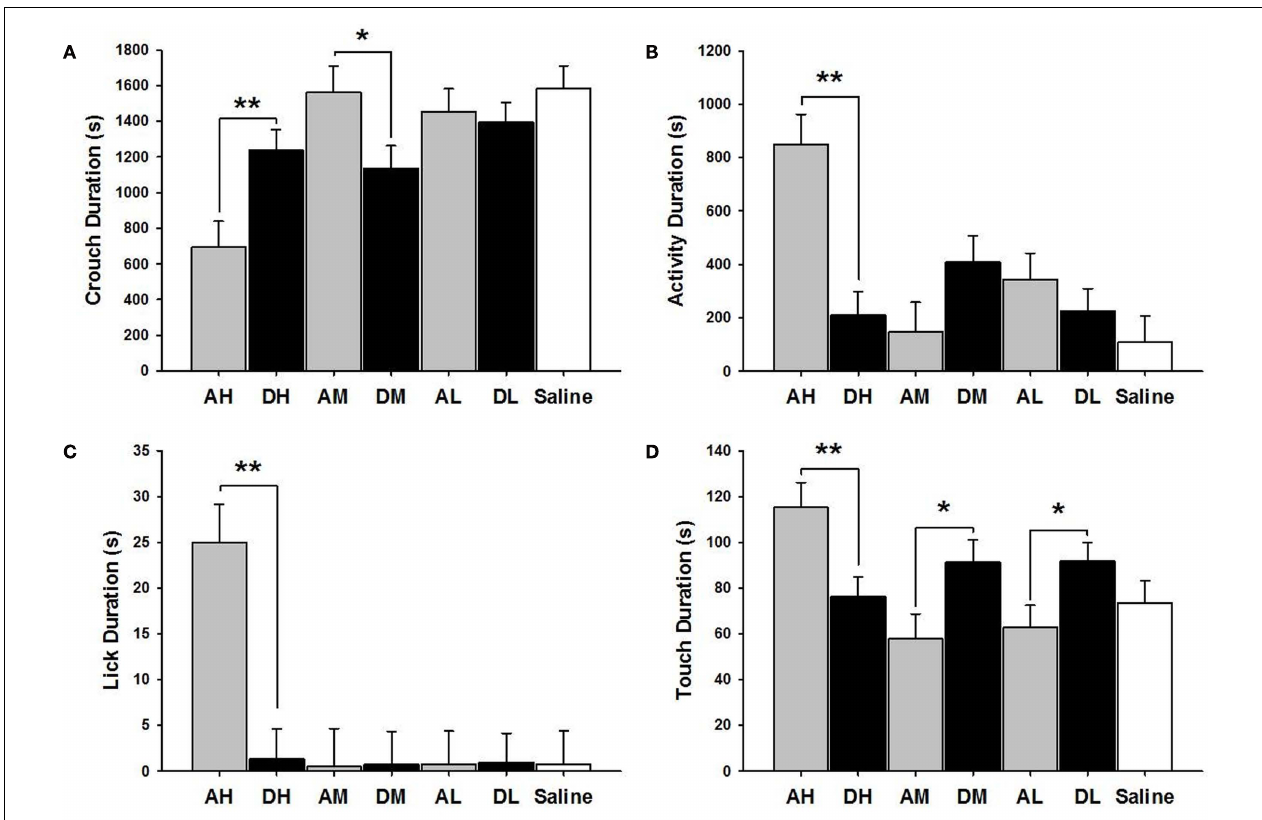
desipramine high (5mg/kg); DM, desipramine medium (5mg/kg); DL, desipramine low (1.25mg/kg)] and saline control group in white [Saline = normal saline (2ml/kg)]. Comparisons between amitriptyline and desipramine groups were only tested between the high, medium, or low dose groups for each respective drug treatment group. All significant AH–DH, AM–DM, and AL–DL comparisons are denoted * p ≤ 0.05; ** p ≤